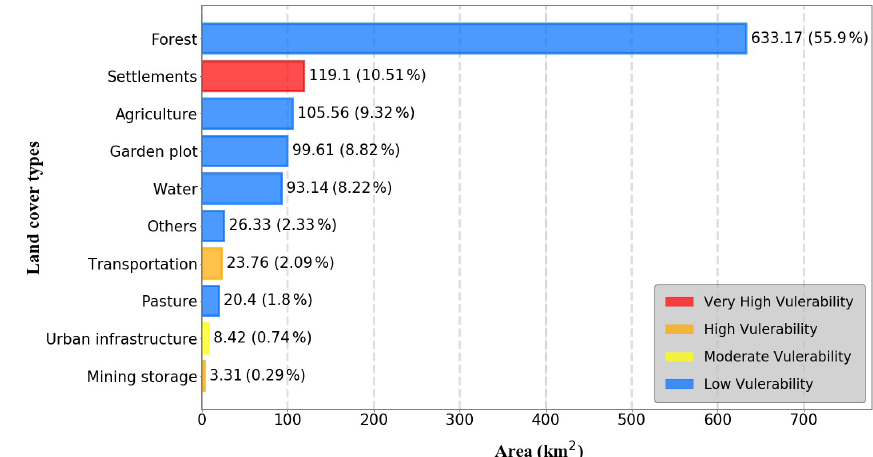
Figure 17. The land areas and proportions of different land cover types in the study area.